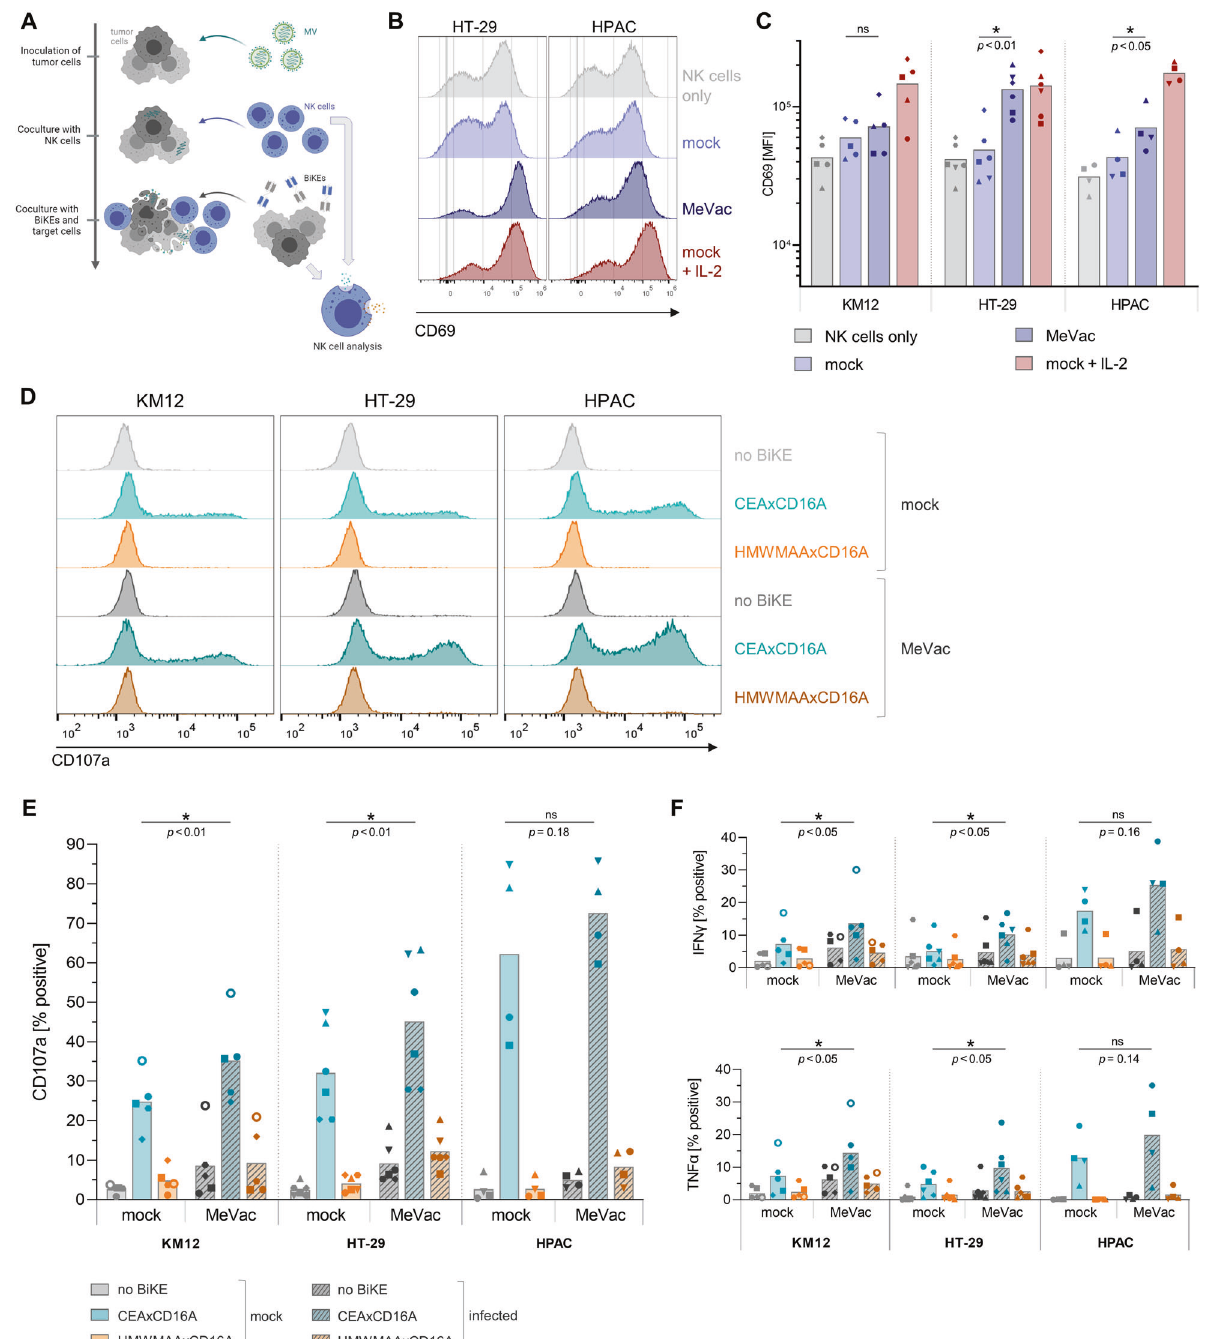
Fig. 1 NK cell activation and effector functions in MV therapy combined with bispeci fi c killer engagers. NK cell activation upon exposure to colorectal cancer (KM12, HT-29) or pancreatic ductal adenocarcinoma (HPAC) cells infected with recombinant measles vaccine strain virus (MV) was assessed in vitro. NK cell degranulation and cytokine expression were monitored in response to MV therapy with subsequent BiKE treatment. A Schematic outline of combination therapy experiments. Colorectal cancer (KM12, HT-29) or pancreatic ductal adenocarcinoma (HPAC) cells were inoculated with MV at a multiplicity of infection (MOI) of 1 or subjected to mock infection one day prior to coculture with NK cells isolated from healthy donor PBMCs. After 12 h co-incubation, i.e., 36 h post inoculation, expression of the early activation marker CD69 was analyzed by fl ow cytometry. NK cell only control and IL-2 stimulated positive control were included for comparison. In further experiments, BiKEs were puri fi ed from supernatants of infected Vero producer cells (vBiKEs). Non-infected target cells and vBiKEs were added to the coculture and incubated for 4 h. NK cell degranulation and cytokine expression were analyzed by fl ow cytometry. B Exemplary histograms depict expression levels of CD69 on live CD45 + CD56 + NK cells after coculture with infected cells compared to control conditions. C CD69 mean fl uorescence intensity (MFI) is summarized for n ≥ 4 donors for each cell line with different symbols representing individual donors. D NK cell degranulation (CD107a) in response to MeVac and vBiKE monotherapy or combination therapy is shown in exemplary histograms for one donor. E Percentages of CD107a + NK cells, F IFN γ + and TNF α + NK cells in different conditions are summarized for n ≥ 4 donors per cell line with different symbols representing individual donors. Statistical analysis was performed by paired t-test for each target cell